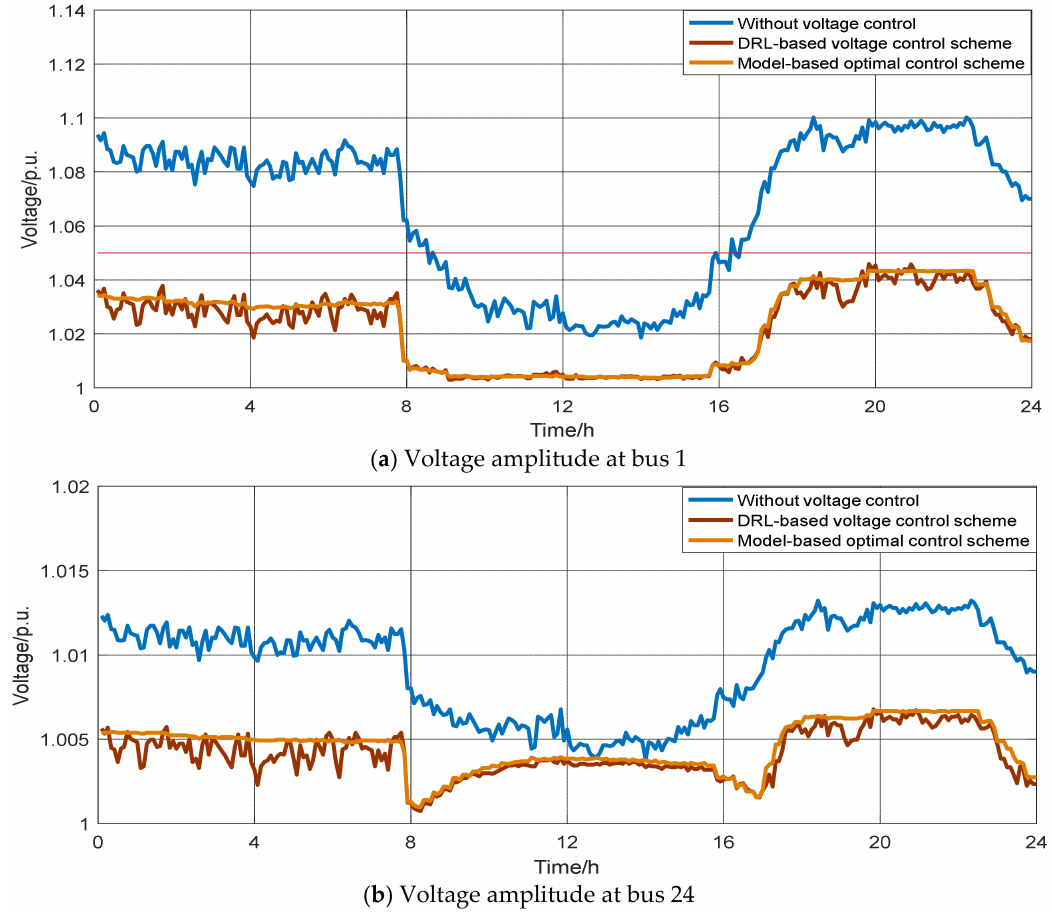
Figure 6. Voltage profiles under different methods on a clear day. ( a ) Voltage amplitude at bus 1, ( b ) Voltage amplitude at bus